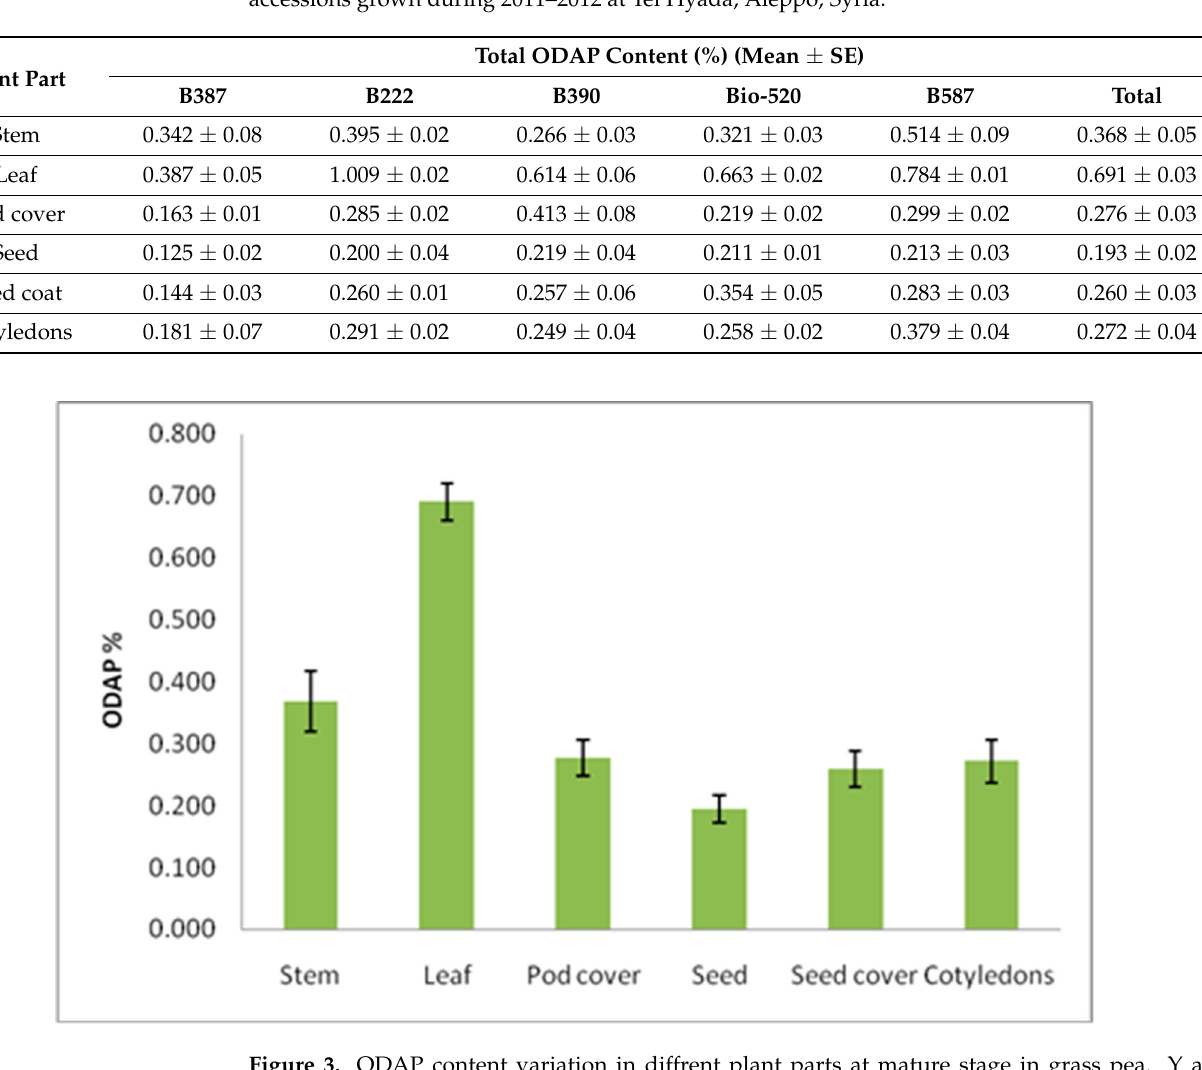
Table 8. Mean total ODAP content (%) in different plant parts at the mature stage in five L. sativus